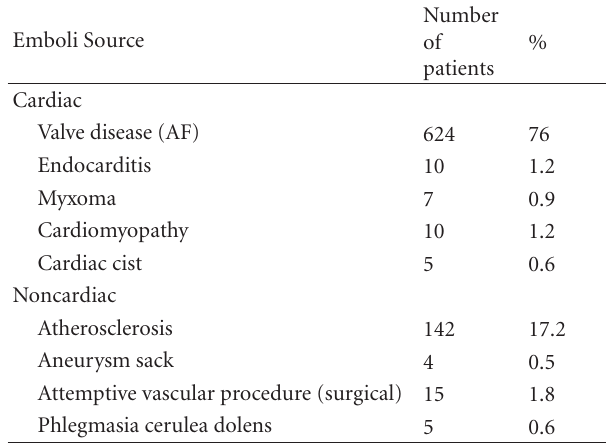
Table 1: The sources leading to acute arterial emboli in our